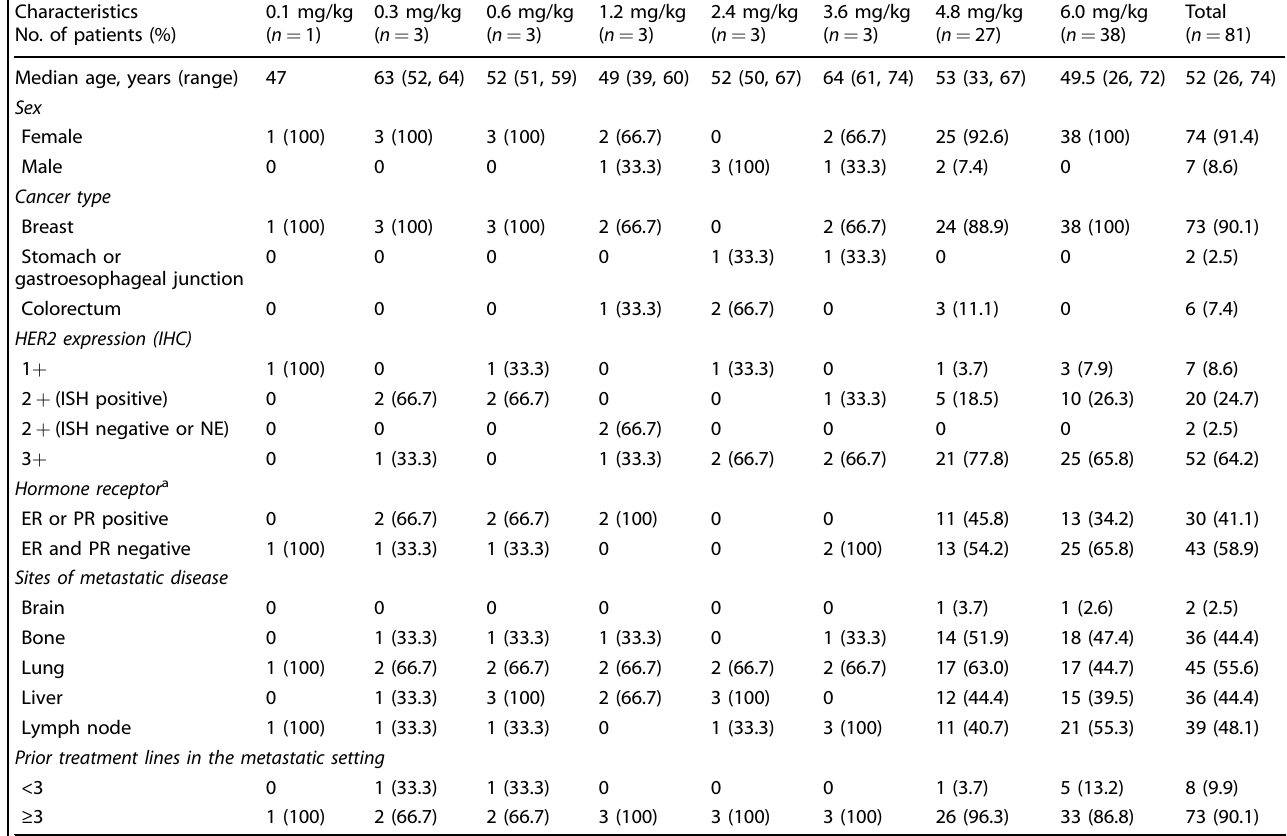
Table 1. Baseline demographic and clinical characteristics. Characteristics No. of patients